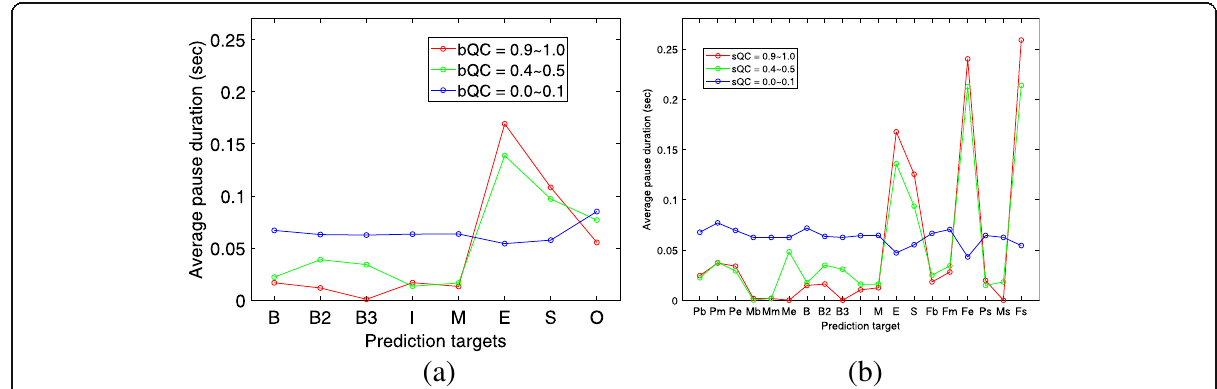
Fig. 11 Average pause durations corresponding to the prediction targets for a bQC and b sQC in different levels of QC